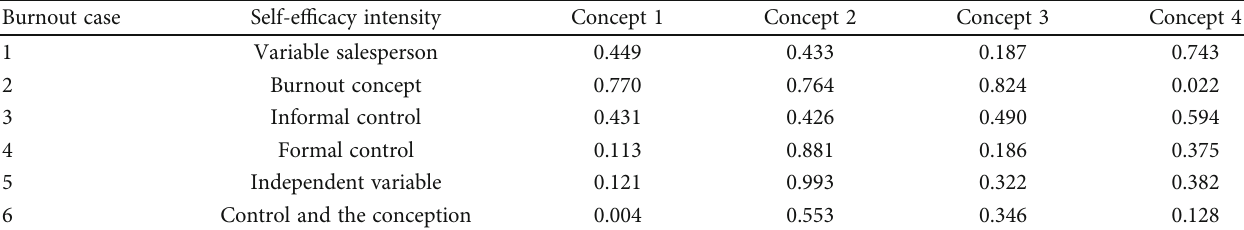
Table 2: Teacher burnout mediating variable self-e ffi cacy